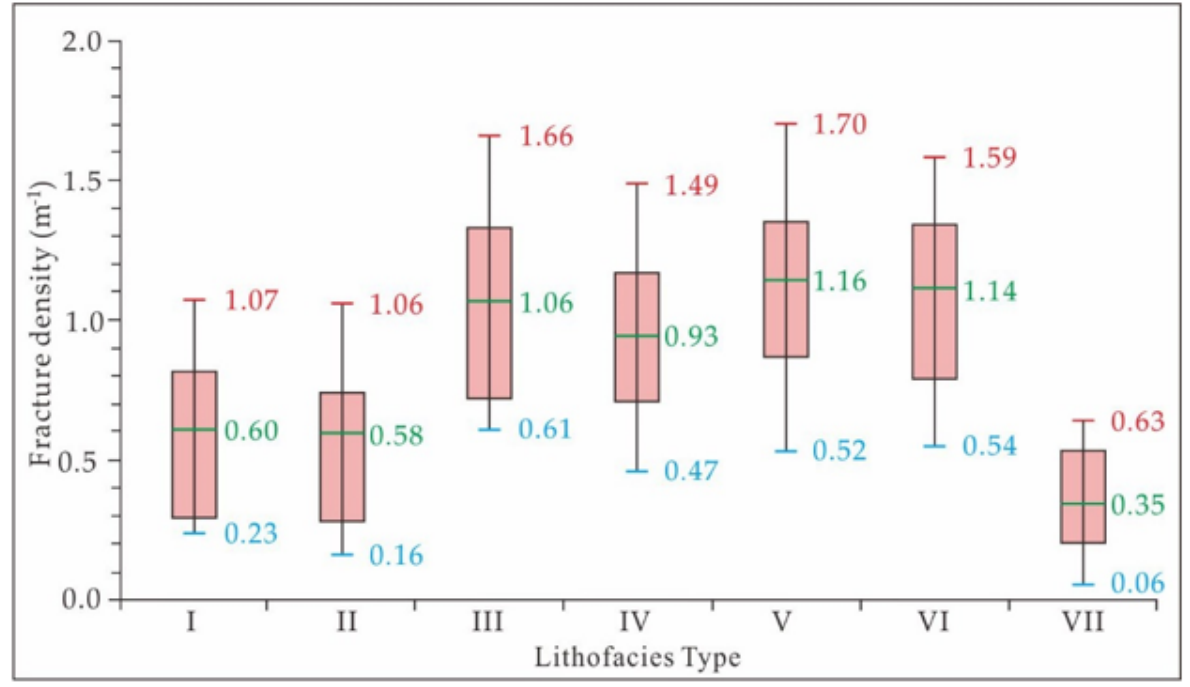
Figure 11. Fracture density in different lithofacies: Type I: high TOC massive siliceous shale; type II: medium TOC massive siliceous shale; type III: medium TOC laminated siliceous shale; type IV: low TOC laminated siliceous shale; type V: low TOC lamelleted siltstone; type VI: low TOC lamelleted limestone; and type VII: high TOC massive argillaceous shale. The short red, green, and blue lines represent the maximum, average, and minimum fracture densities, respectively.